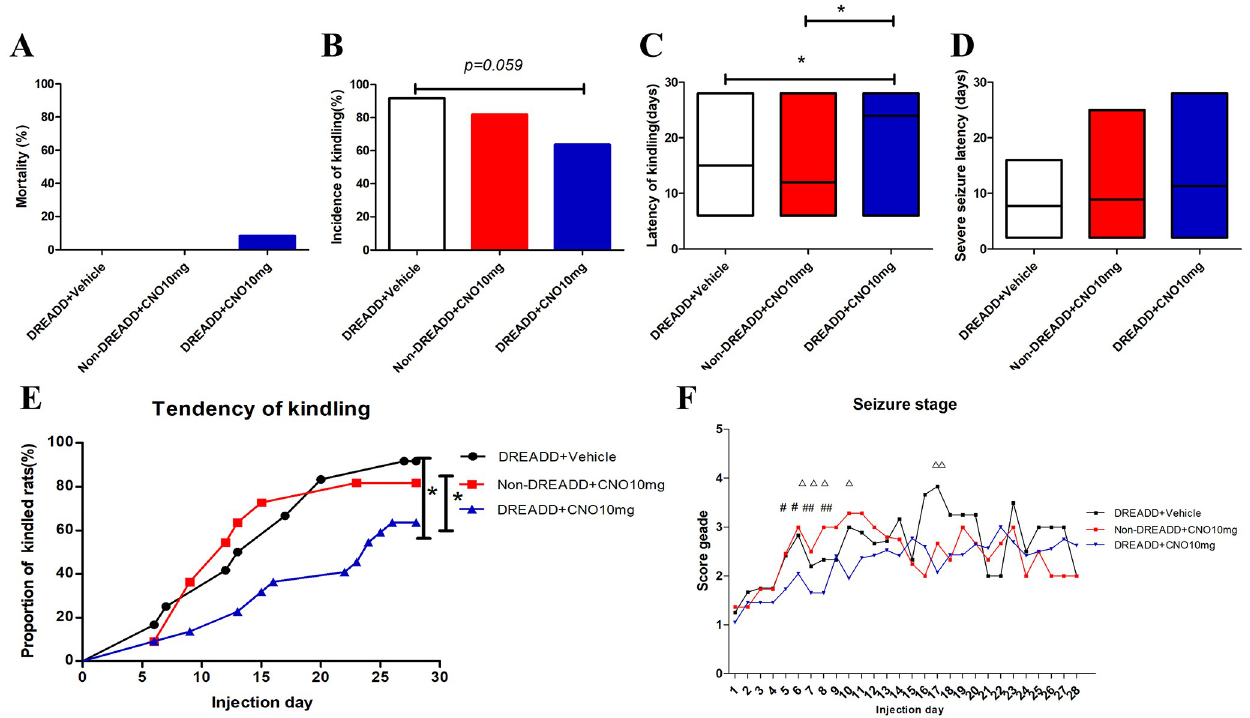
Fig 2. CNO administration alleviates epileptogenesis in PTZ kindling rat model infected with hM4Di vector in DG. Mortality(A), kindling rate(B), latency of kindling(C), severe seizure latency(D), tendency of kindling(E) and seizure stage(F) of two control groups and DREADD+CNO group. * indicates P < 0.05, ** indicates P < 0.01; Δ Indicates P < 0.05, ΔΔ indicates P < 0.01,DREADD+CNO group vs DREADD+Vehicle group;# Indicates P < 0.05, DREADD+CNO group vs Non-DREADD+CNO group; CNO, clozapine N-oxide.